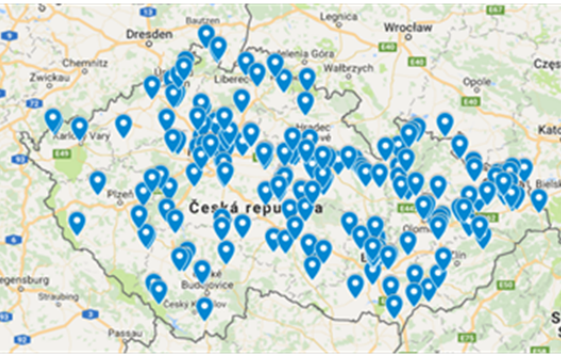
Figure 4. Places of railway incidents in the Czech